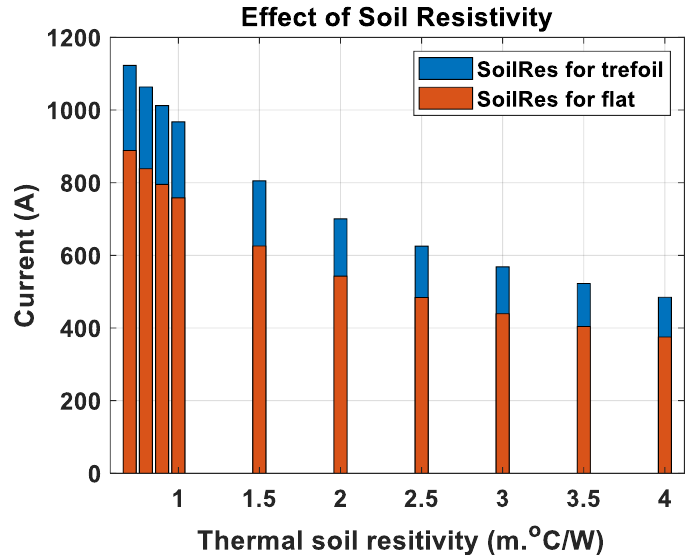
Figure 8. Effect of the thermal soil resistivity on the cable